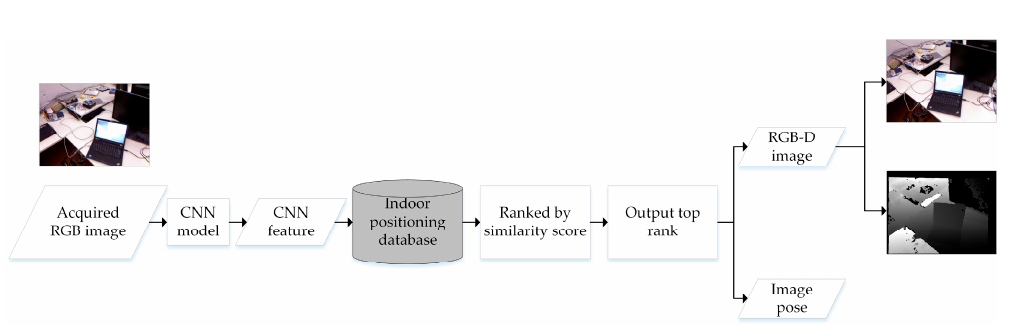
Figure 5. Process of the convolutional neural network (CNN) feature-based image retrieval.